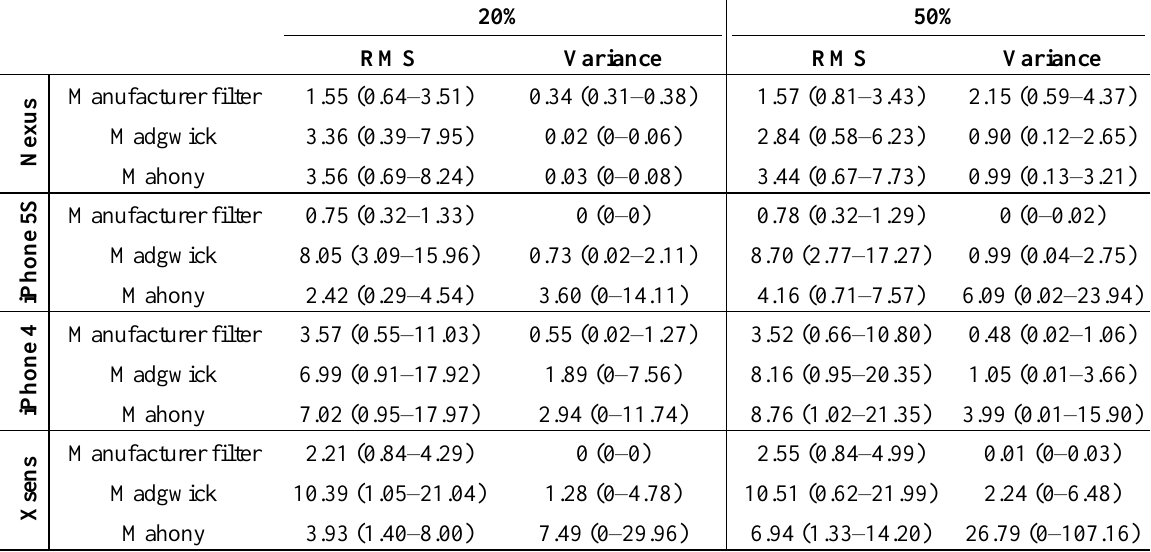
Table 4. Dynamic protocol results, mean (min–max), for roll at rates of 20% and 50% of the maximum velocity in degrees.